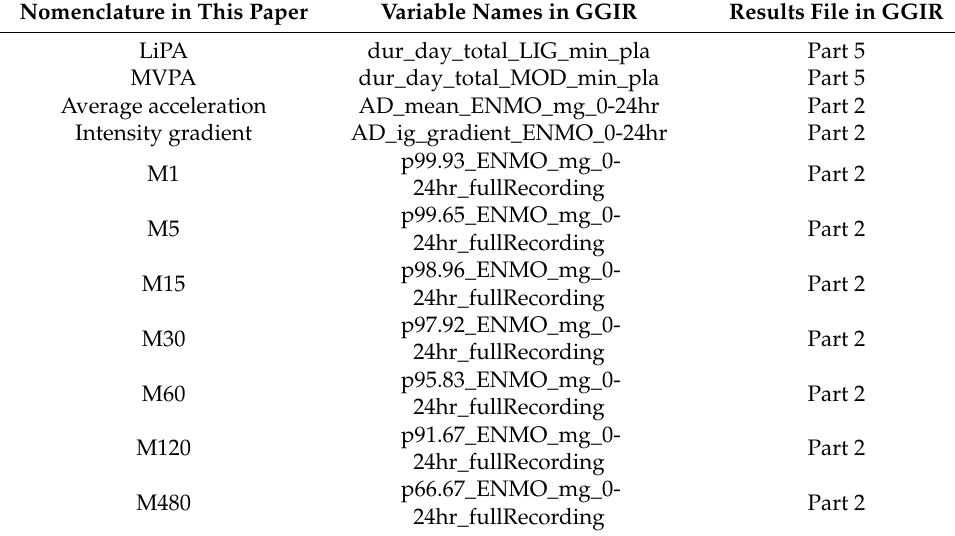
Table 1. Correspondence between the nomenclature of the present paper and variable names from GGIR